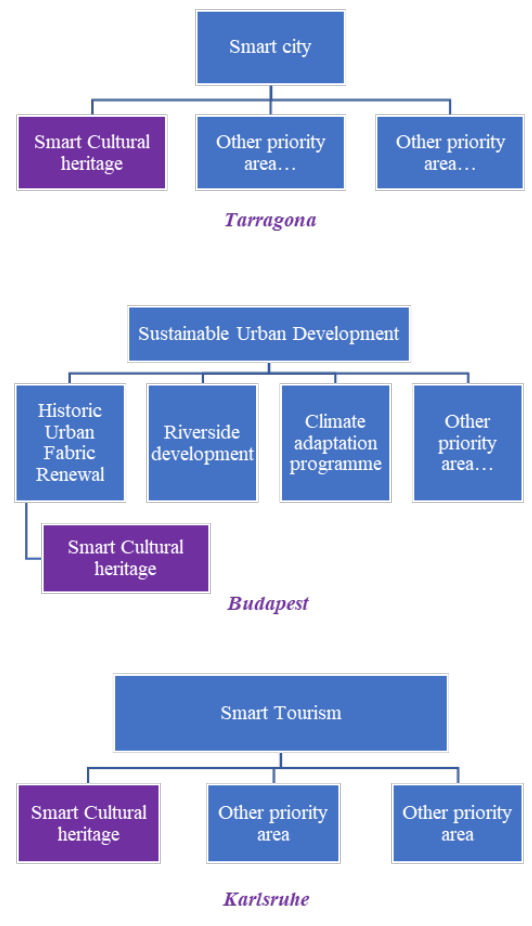
Figure 14. Three different strategy architectures that connect the smart city, cultural heritage and sustainable urban development (authors’